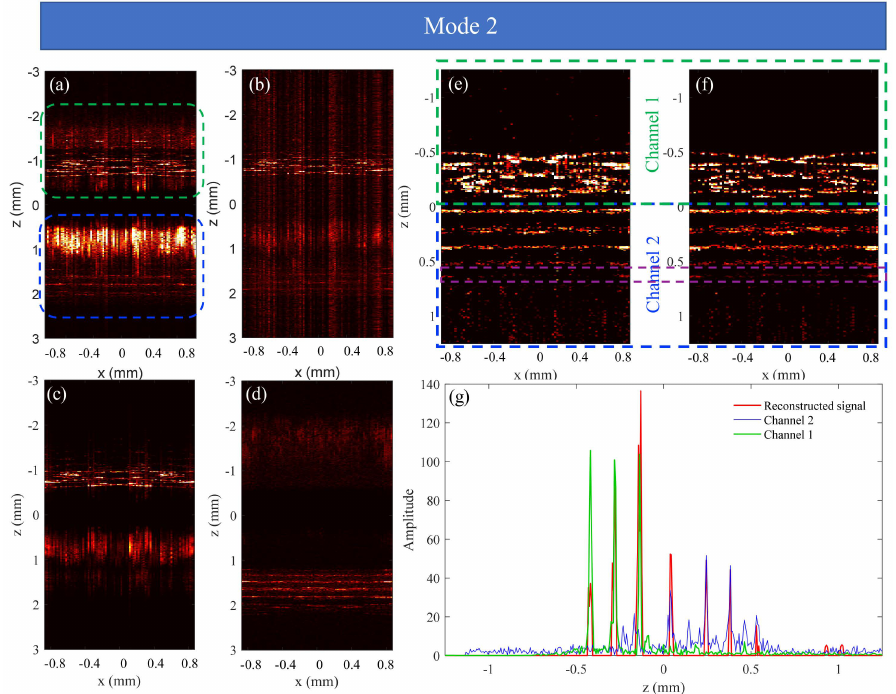
Figure 8. Experiment results of an onion. The results in ( a , c ), and ( d ) are obtained using complete spectral data, and the result in ( b ) is obtained using 50% spectral data. Panels ( e ) (50% data) and ( f ) (100% data) show images of an onion that are stitched together by the results of the two channels; Panel ( g ) shows the depth signals at x = 0